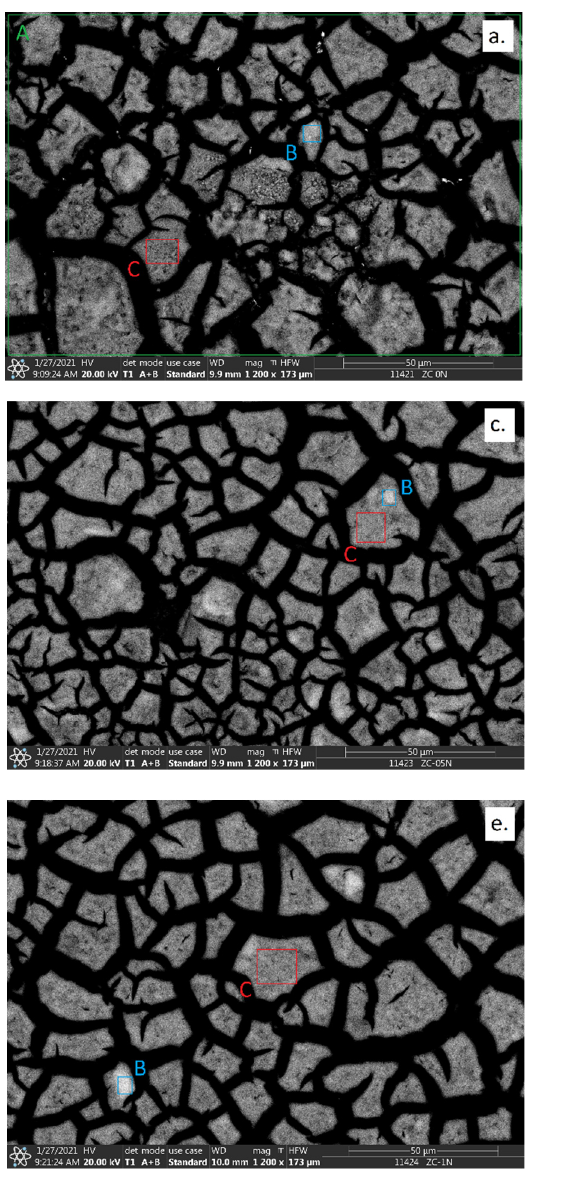
Figure 7. SEM images of Cat-0N-0H ( a ), Cat-0N ( b ), Cat-1N-0H ( c ), Cat-1N ( d ), Cat-2N-0H ( e ), and Cat-2N ( f ). The rectangles indicate the area analyzed by EDS. The “whole area” is not signed (by a green A) in the case of ( c – f ). Table 4. The Zn:Cd atomic ratios of the investigated catalysts calculated from the EDS analyses of different areas: A: average values regarding the whole area shown in the SEM pictures, B: the aver- age of some lighter spots, and C: the average of a darker area.